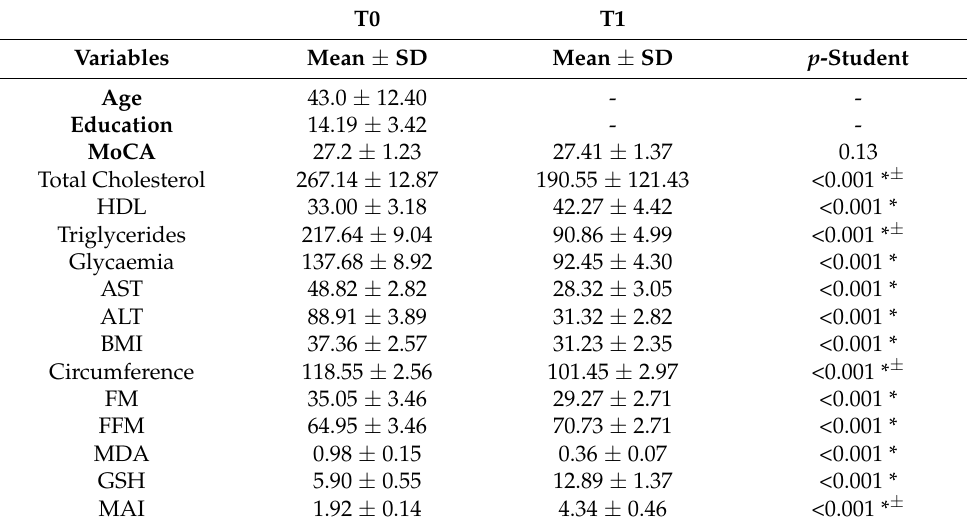
Table 1. Demographic and clinical characteristics of sample. T0